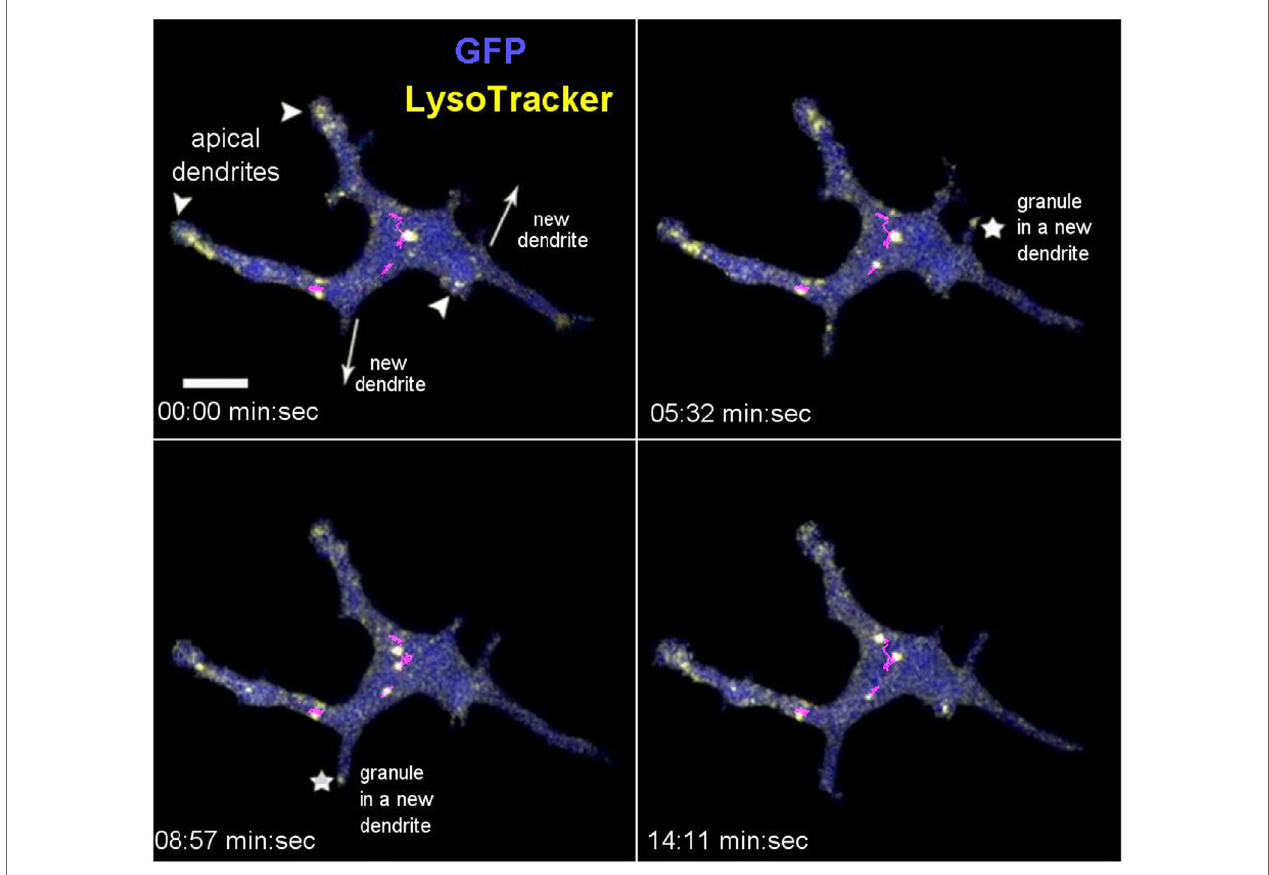
FigUre 3 | In vivo dynamics of dendritic epidermal T cell granules labeled with LysoTracker. The panel shows maximum intensity projections from a video sequence. The arrowheads point to the apical dendrites (based on 3-D inspection), the arrows indicate the direction of new dendrite growths, and the asterisks indicate the accumulating granules. The magenta lines represent tracks of several mid-body granules (see Movie S1 in Supplementary Material). Scale bar = 5